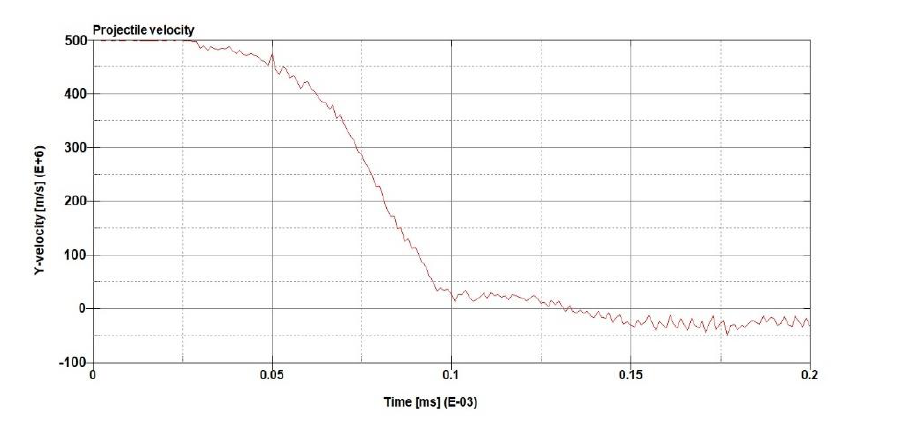
Figure 15 – Velocity of the projectile in relation to time Рис. 15 – Cкорость снаряда в зависимости от времени Слика 15 – Брзина пројектила у зависности од времена